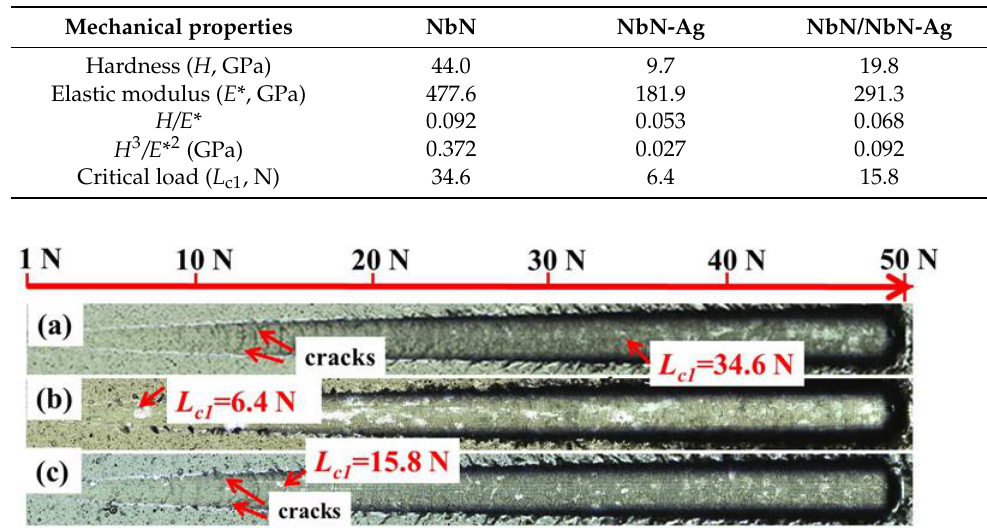
Figure 4. Optical microscope images of typical scratch morphologies of the films: ( a ) NbN; ( b ) NbN-Ag; ( c ) NbN/NbN-Ag.